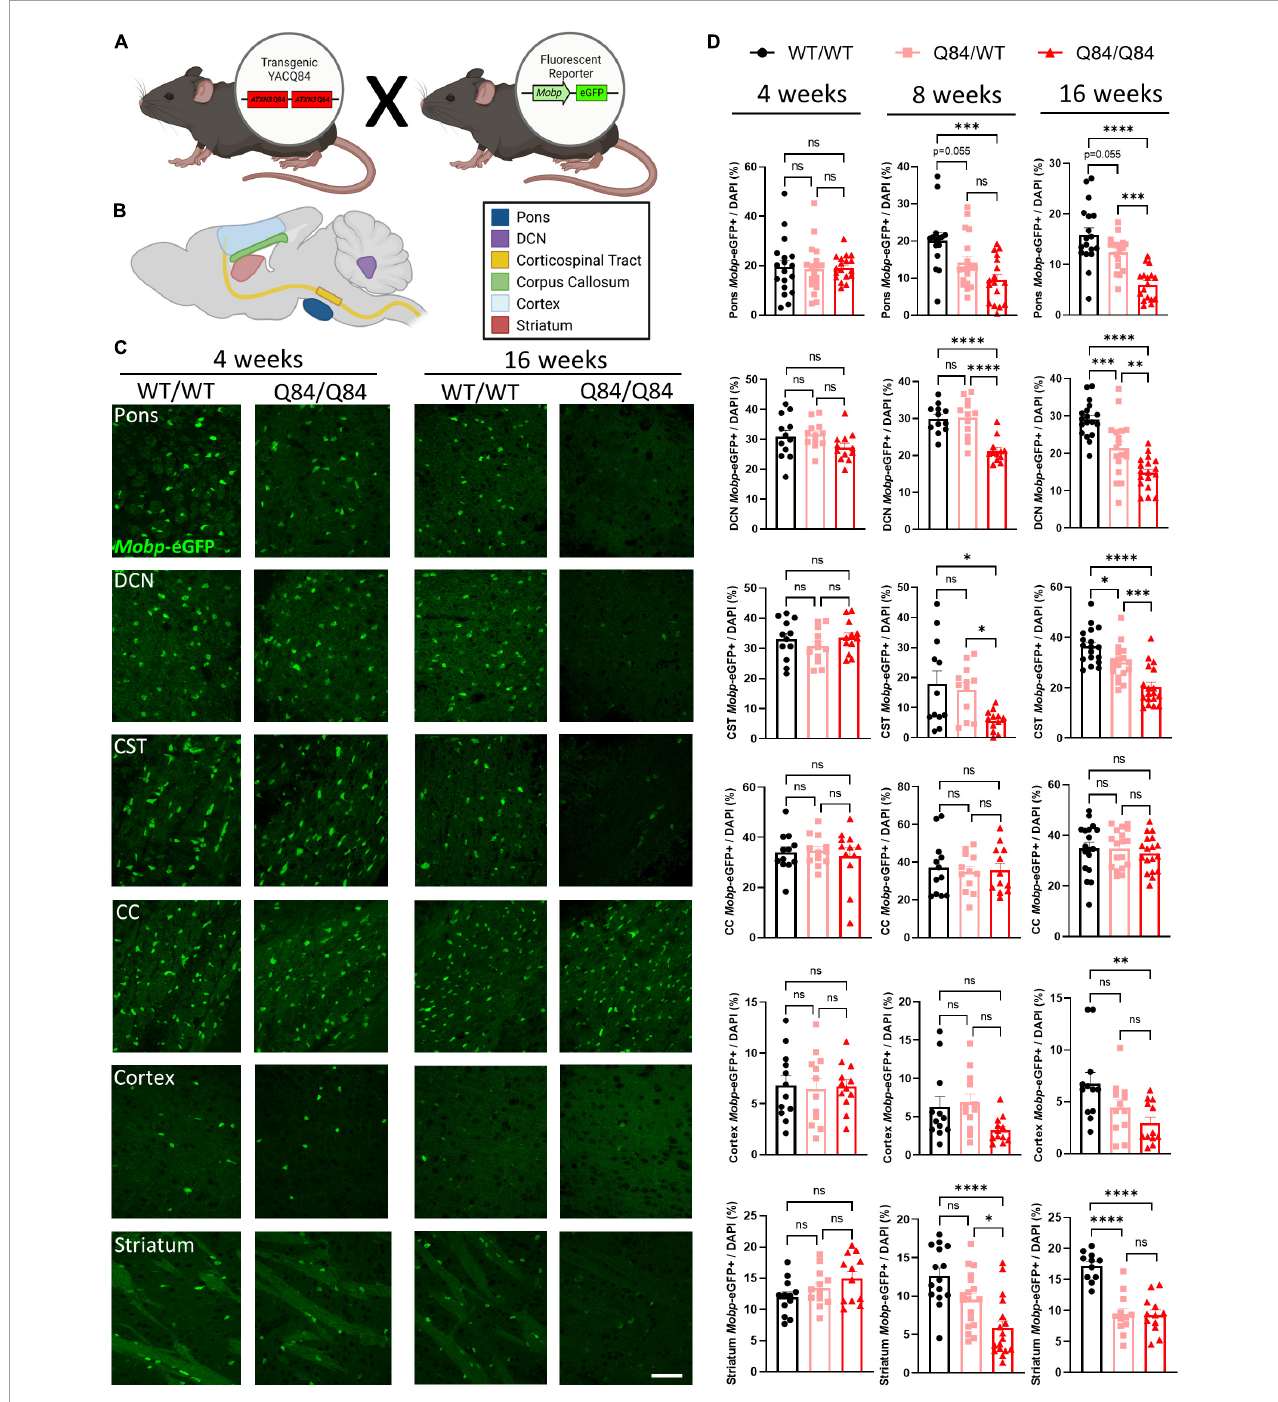
FIGURE4 Mature oligodendrocytes are reduced in a spatiotemporal pattern that corresponds to disease progression. (A) Mouse cross between Q84 SCA3 mice and Mobp -eGFP reporter mice. (B) Depiction of where images were taken for histologically assessed regions. (C) Representative images of Mobp -eGFP+ mature oligodendrocytes in the pons, DCN, CST, CC, cortex, and striatum at 4 weeks (left) and 16 weeks of age (right). Scale bar 50 µ m. (D) Quantification of mature oligodendrocytes in the pons, DCN, CST, CC, cortex, and striatum of Q84; Mobp -eGFP+ mice at 4 (left), 8 (middle), and 16 weeks of age (right) ( n = 4–6 mice/genotype, 3 images/mouse). One-way ANOVA with a post-hoc Tukey’s multiple comparisons test was performed: ∗ p < 0.05, ∗∗ p < 0.01, ∗∗∗ p < 0.001, ∗∗∗∗ p < 0.0001; ns, not significant.